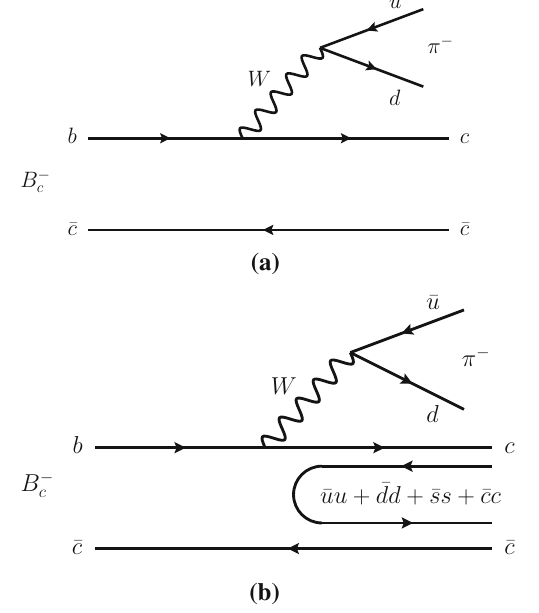
Fig. 1 a Microscopic quark picture of B − c → π − c ¯ c decay.